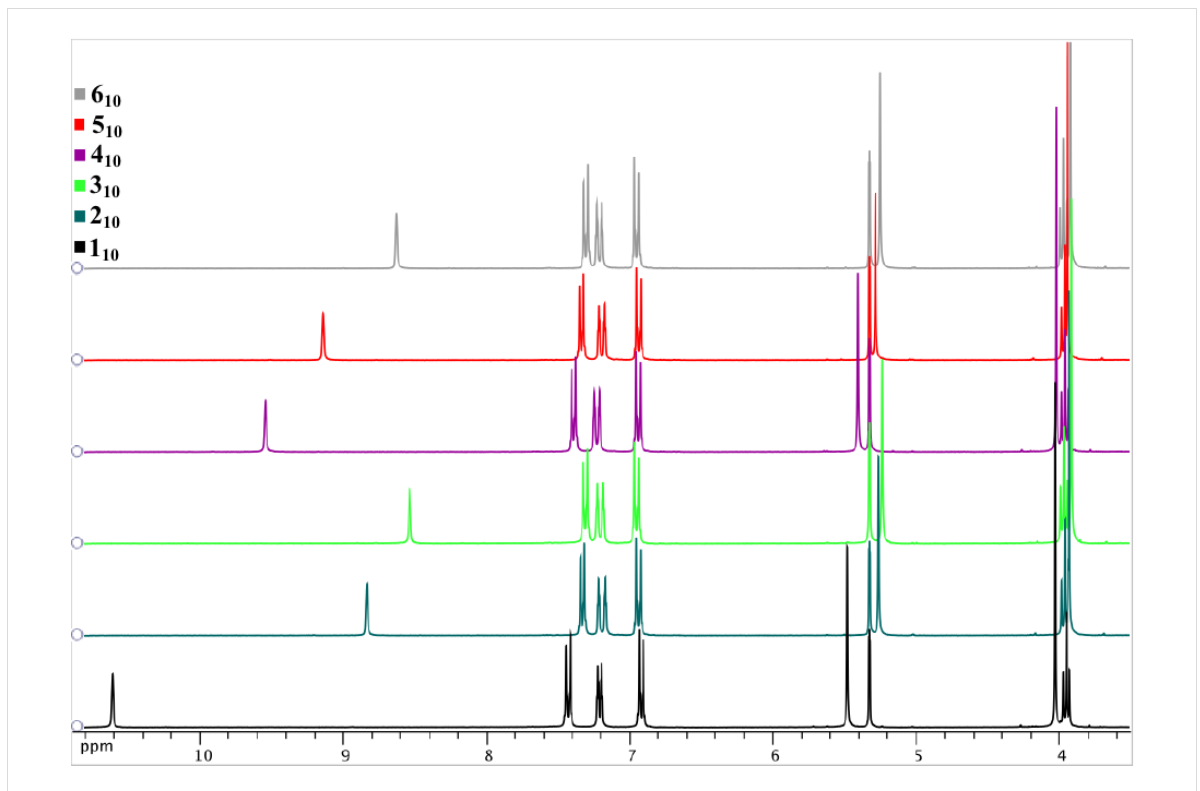
Figure 1: 1 H NMR spectrum (in CD 2 Cl 2 ) of 1 10 – 6 10 .